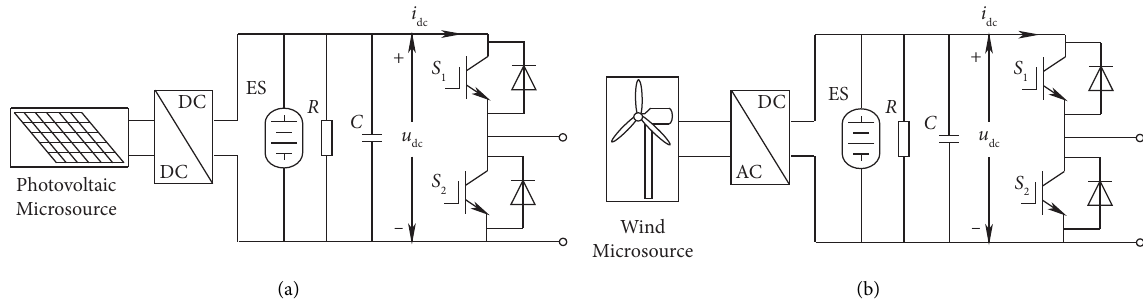
Figure 1: Topology structure of GM. (a) Photovoltaic GM topology and (b) wind power GM topology.